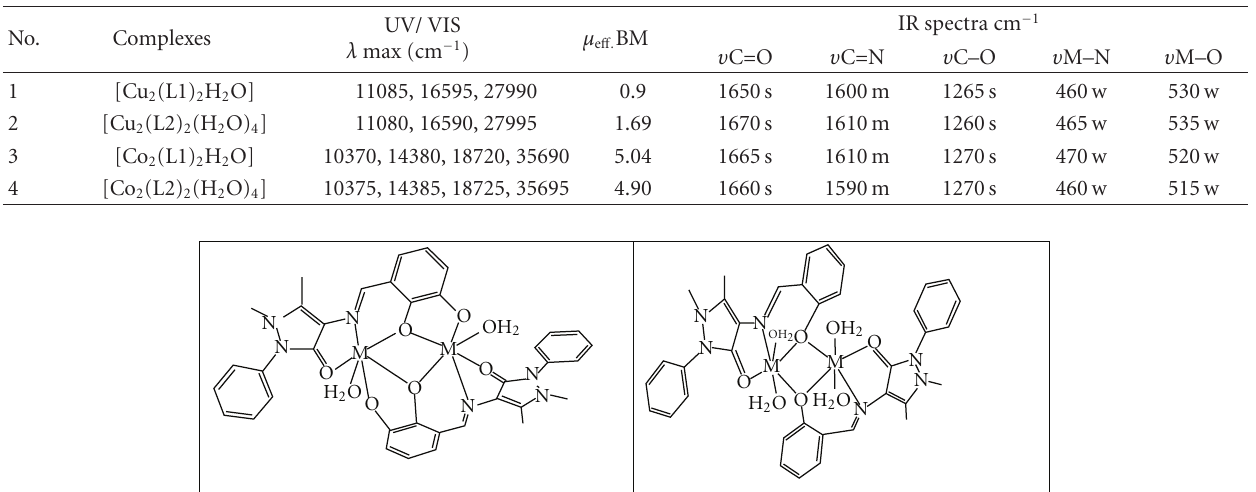
Table 2: Characteristic IR and electronic spectral data of the metal complexes.